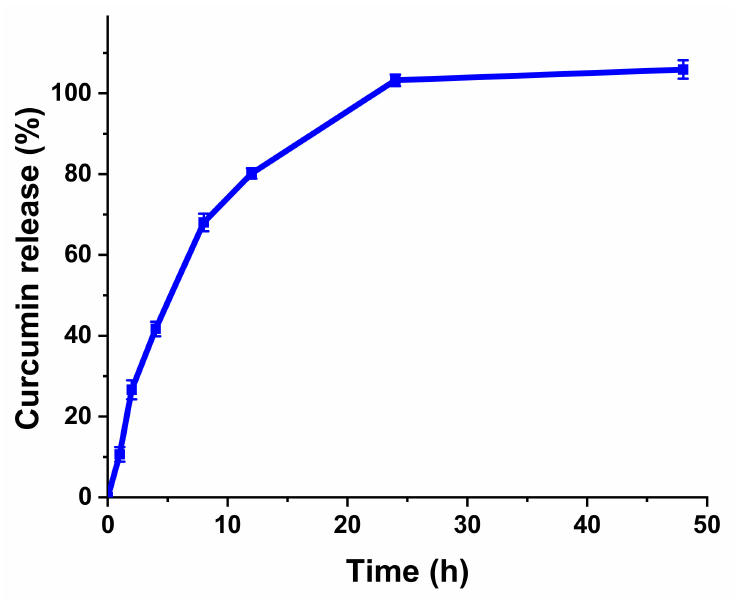
Figure 7. In vitro curcumin release behavior of PTHG-B in PBS containing 20% ethanol. Error bars showing standard deviation (n =